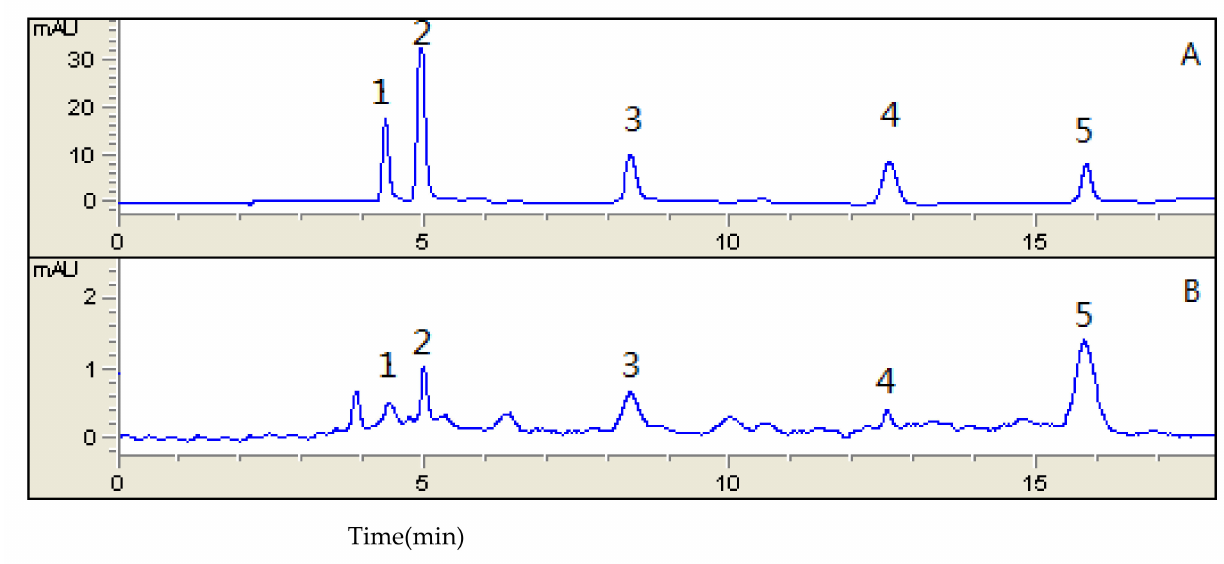
Figure 2. Chromatograms of a mix of standard carotenoids ( A ) and carotenoids extracted from cultivar ‘Jintong7’ ( B ). (1) Lutein, (2) Zeaxanthin, (3) β -Cryptoxanthin, (4) α -Carotene, and (5) β